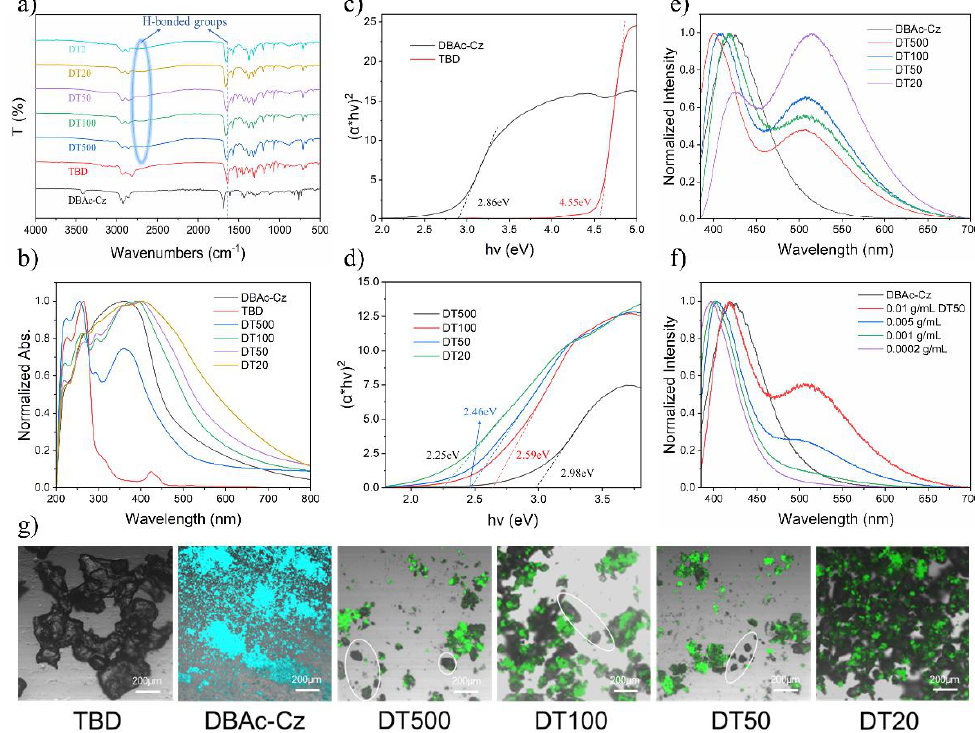
Figure 4. ( a ) FT-IR spectra and ( b ) UV-vis diffuse reflection spectra of DBAc-Cz, TBD, DT500, DT100, DT50, DT20 (DT2: DBAc-Cz/TBD = 1/2 mole ratio). Tauc plots and the calculated band gaps of ( c ) DBAc-Cz, TBD and ( d ) DT. ( e ) Steady-PL spectra of DT solution in DCM (0.01 g/mL). ( f ) Steady-PL spectra of different density (0.01 g/mL, 0.005 g/mL, 0.001 g/mL, 0.0002 g/mL) of DT50 solution in DCM. ( g ) Photographs of TBD, DBAc-Cz and DT (excited by 405 nm UV), non-photoluminescent particles were marked by white ellipse.